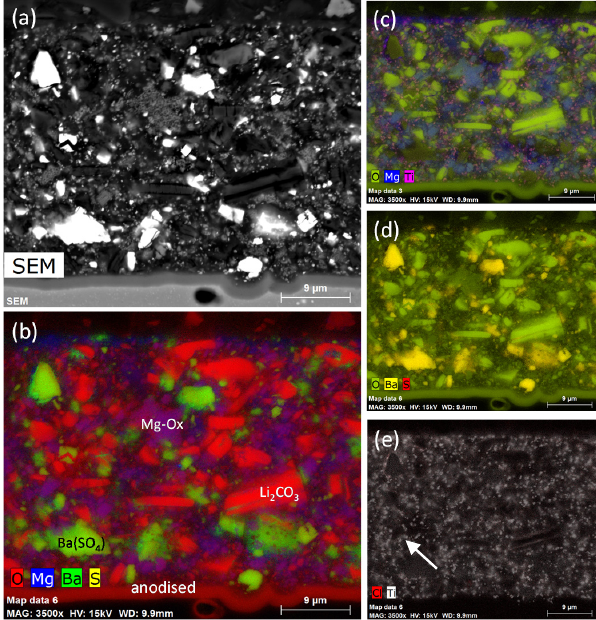
Figure 5. EDS mapping results for sample without exposure to neutral salt spray (NSS). ( a ) Backscattered electron image and maps derived from quantitative analysis, and composite maps for ( b ) O ‐ Mg ‐ Ba ‐ S with phase labelling ( c ) O ‐ Mg ‐ Ti, ( d ) O ‐ Ba ‐ S and ( e ) Cl ‐ Ti map. (N.B. colour mixing is not the same as three ‐ colour mixing). The Li 2 CO 3 was assigned on the basis that only O and C were detected at any significant levels. The arrow tip in ( e ) indicates where a very low amount of chlorine was detected.